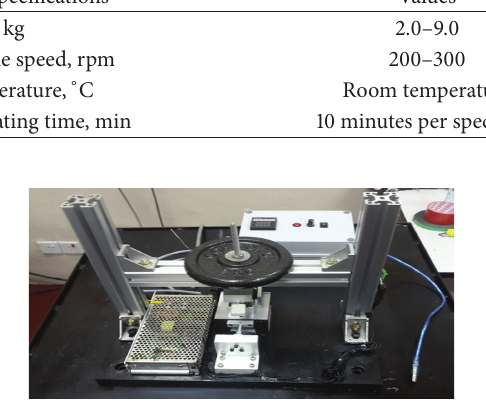
Figure 1: Piston ring reciprocating liner test machine, contact geometry, and test specimen.